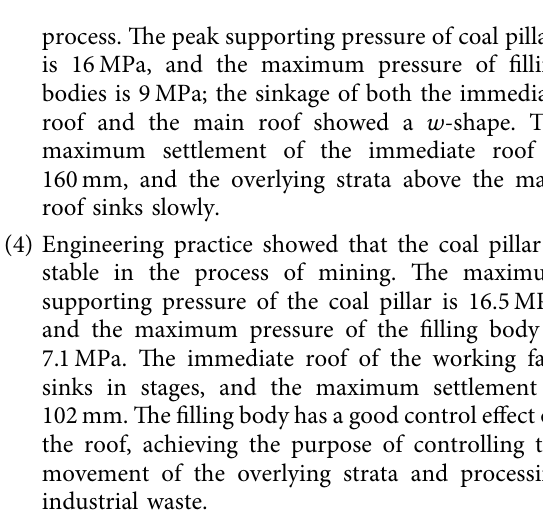
Figure 15: Backfilling body. (a) The exposed filling body. (b) The top of the filling body. (c) Coal pillar.